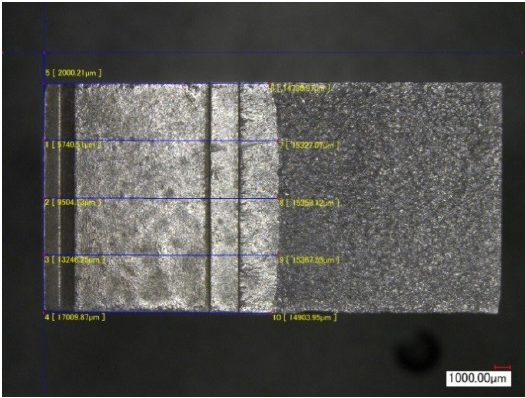
Figure 6. Fatigue crack length measurement.